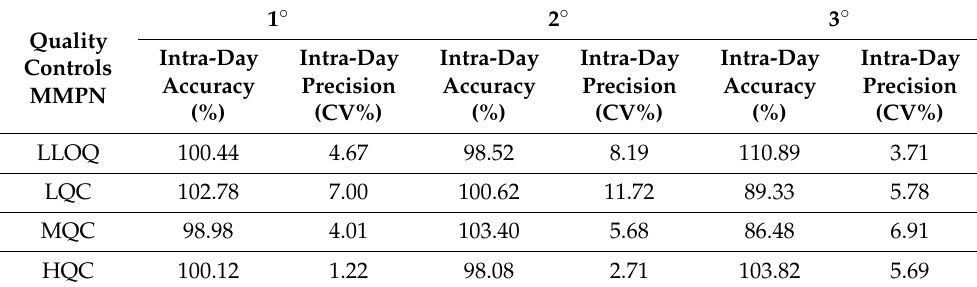
Table 7. Intra-day accuracy and precision (CV%) referred to QCs of MMPN.